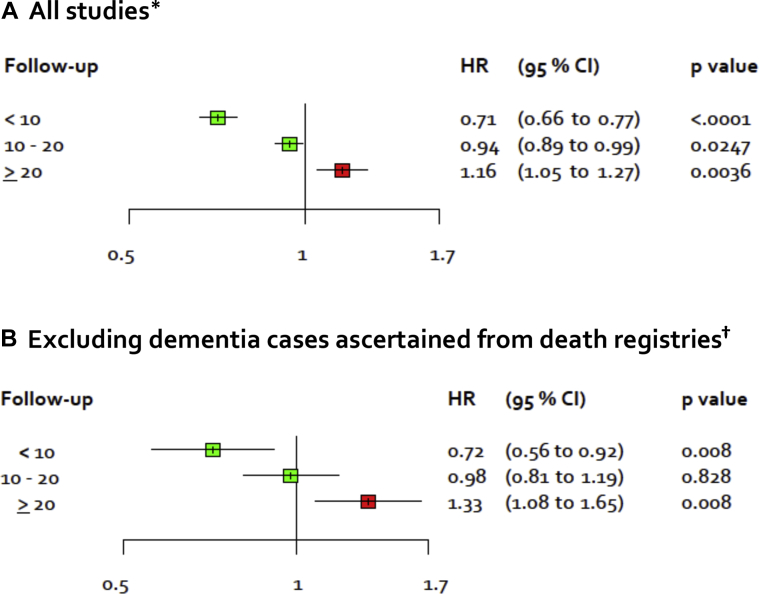
Age-, sex-, and ethnicity-adjusted hazard ratio for dementia per 5-kg/m2 increase in BMI in analysis stratified by follow-up period in all studies (A) and in studies with dementia ascertainment using dementia morbidity data (B). ∗39 studies, total N = 1,349,857. †5 studies, total N = 95,851. The figure shows that risk of bias due to preclinical dementia is smaller at later follow-up periods. Abbreviations: BMI, body mass index; CI, confidence interval; HR, hazard ratio.